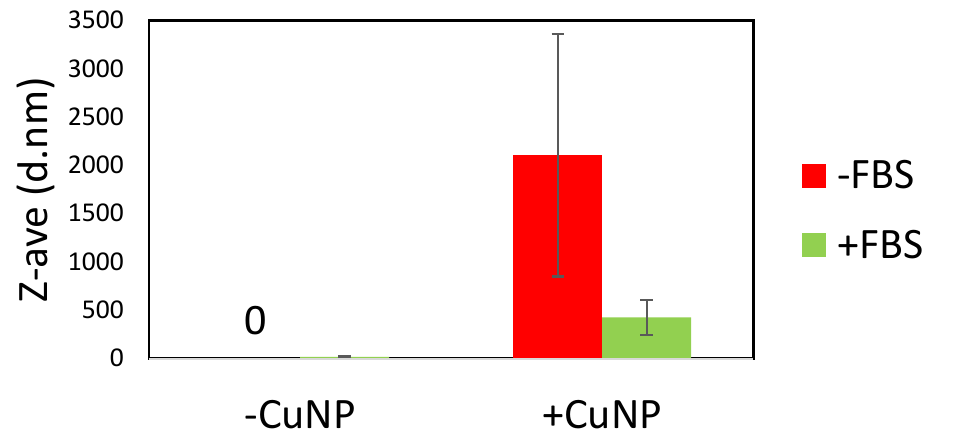
Figure 1. The Z-average of a 10 min probe-sonicated 20 µg/mL suspension of 40–60 nm copper nanoparticles (CuNPs) in media with and without FBS. The conditions were replicated in media without CuNPs as a control.